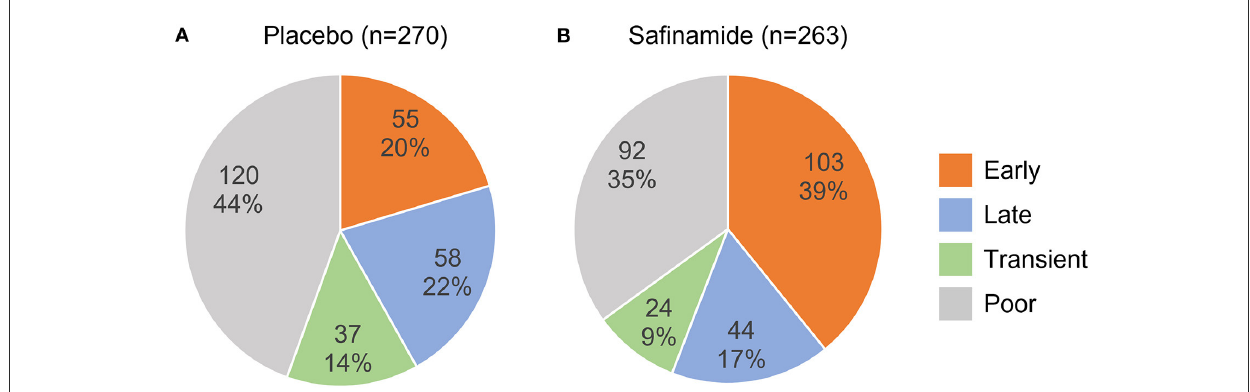
FIGURE2 Distribution of responder subgroups in the placebo (A) and safinamide (B) groups. The upper and lower numbers are the number and the percentage, respectively, of each responder subgroup in the treatment group. The distributions are significantly different between the treatment groups ( p < 0.0001, Chi-squared